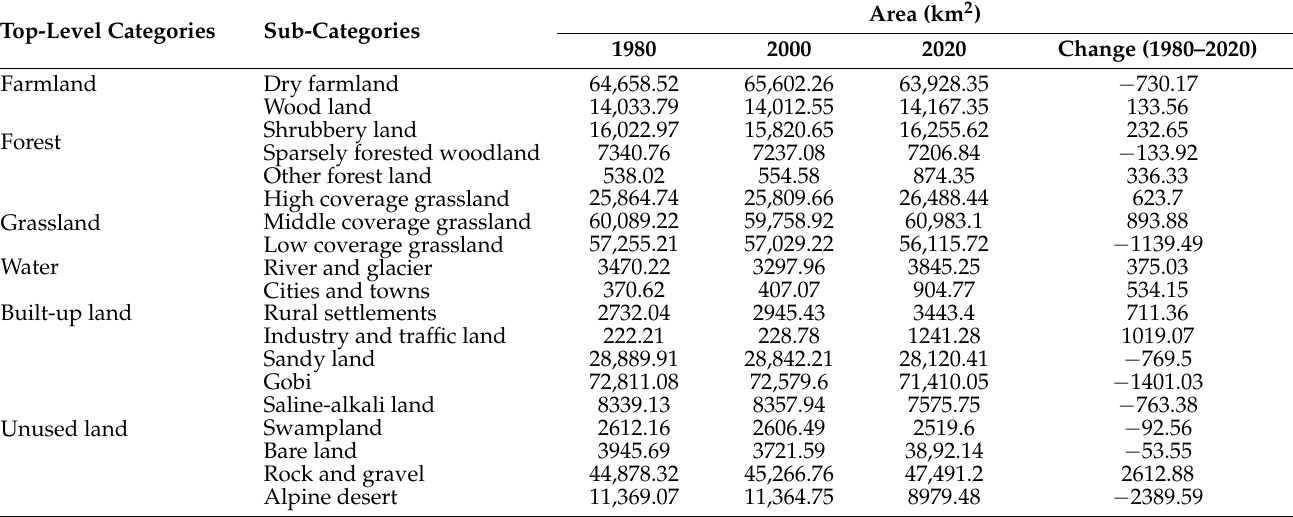
Table 3. Land-use changes in the Gansu province from 1980 to